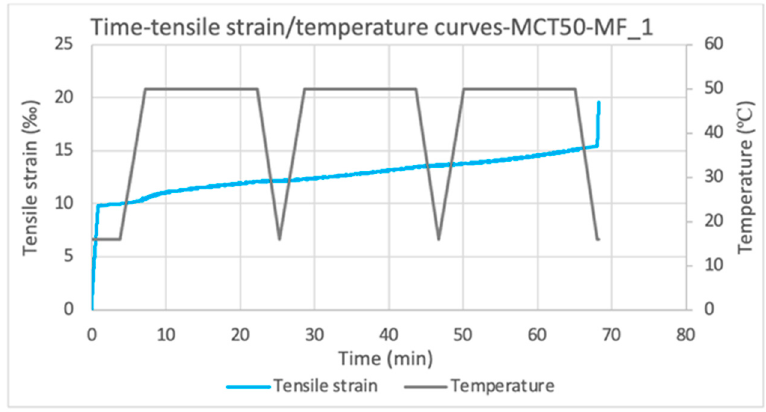
Figure 18. Time–strain/temperature curves of MCT50-MF_1.